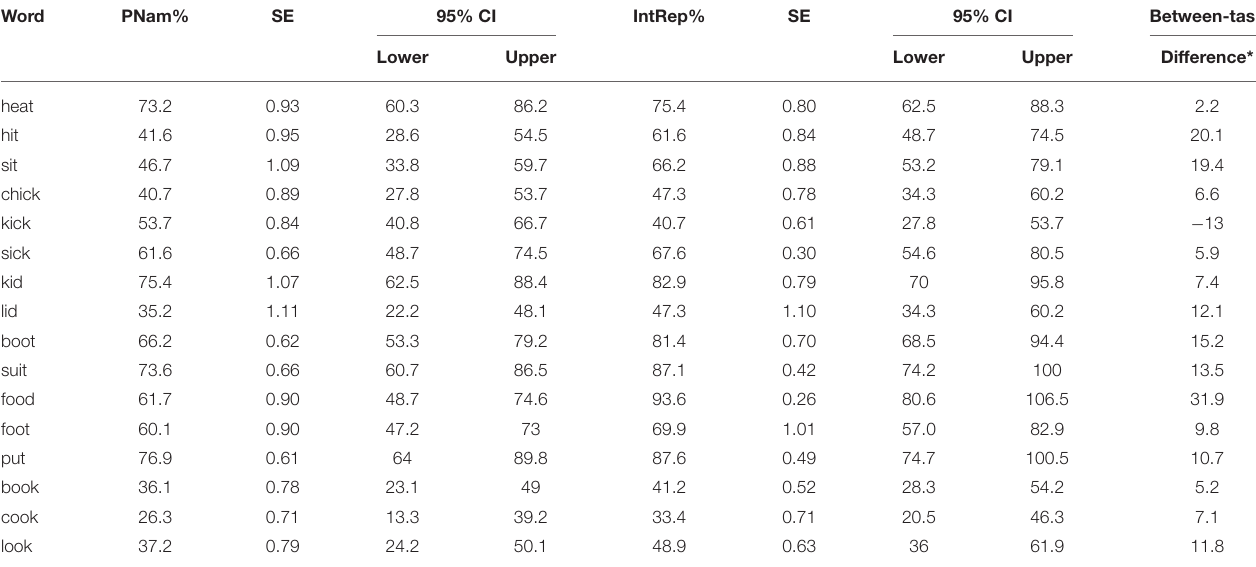
TABLE 6 | Mean intelligibility by word and task (included words only).